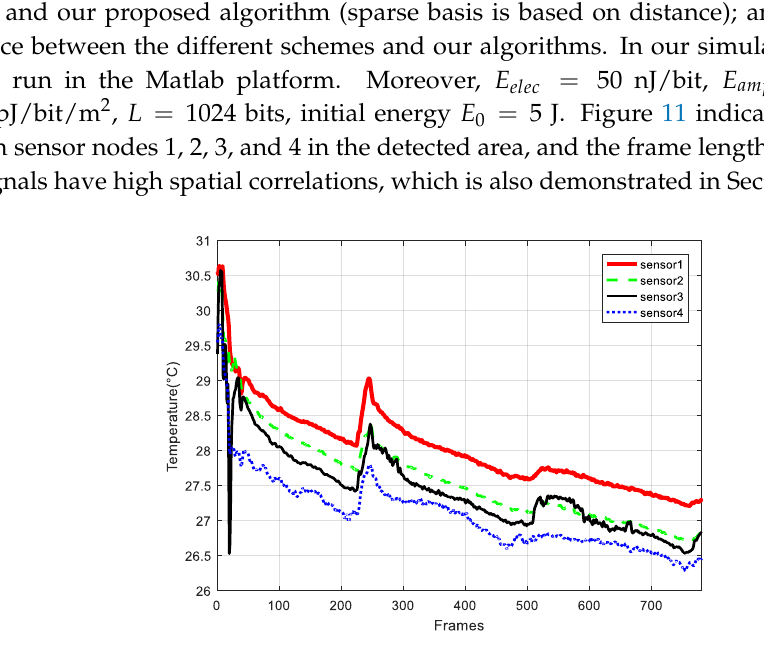
Figure 11. Original signal with different sensor nodes from DEI datasets.